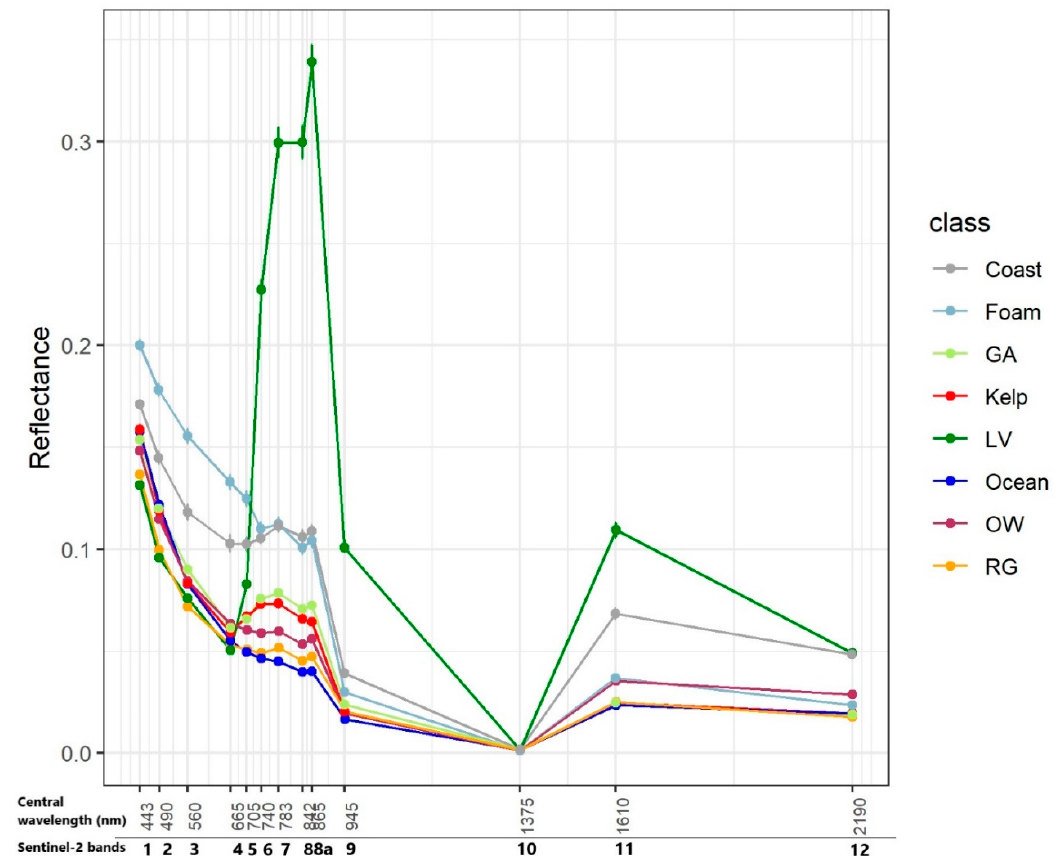
Figure 1. Mean ± SD reflectance values for each Region of Interest (ROI) used as training data in this study, computed for all Sentinel-2 bands (central wavelength of each band (in nm) and band number indicated in the × axis). Classes or ROIs: Coast ; Foam ; GA = Green Algae ; Kelp ; LV = Land vegetation ; Ocean ; OW = Organic water ; RG: River grass .